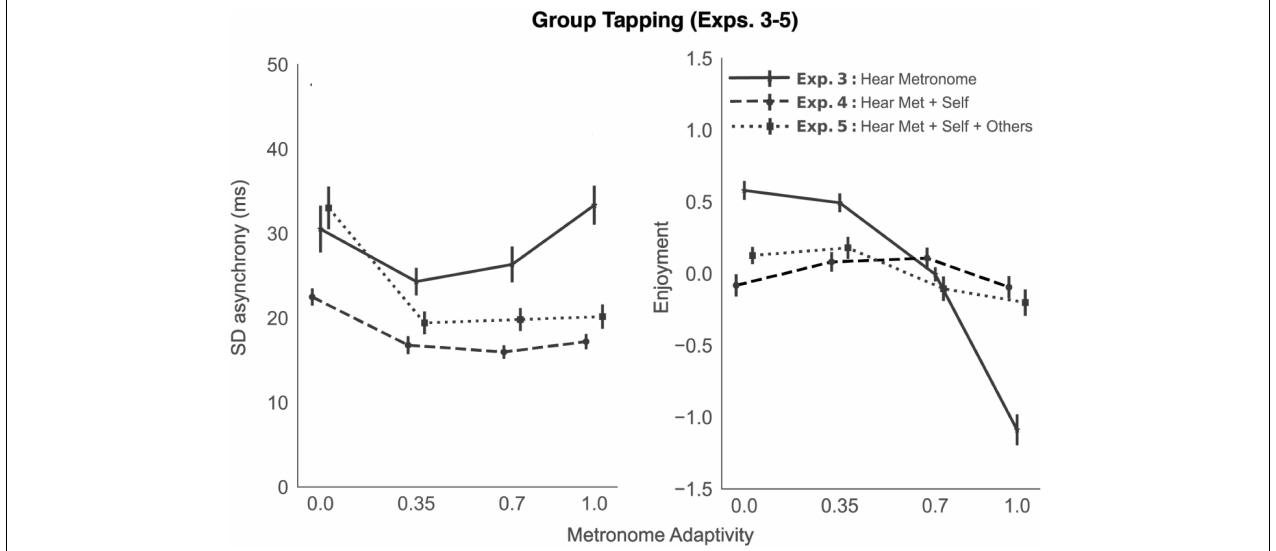
FIGURE 4 | Tapping performance and subjective enjoyment, averaged across participants, as a function of metronome adaptivity, in the three group tapping experiments. Solid black lines represent experiments in which participants could only hear the sound produced by the metronome; dashed lines, experiments in which participants could hear the metronome and the sound of their own tap; dotted lines, experiments in which participants could hear the metronome, themselves, and all others in the group. Error bars represent standard error of the mean.